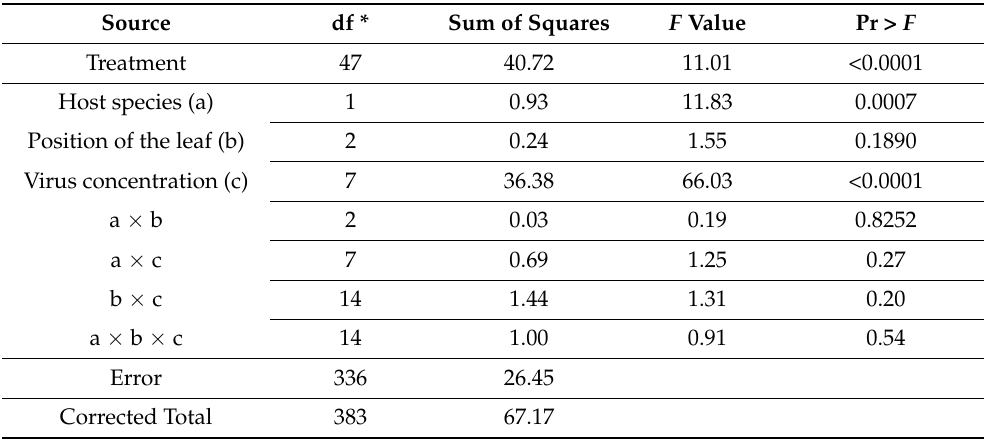
Table 5. ANOVA test results for evaluation of effects of leaf position and type of local lesion host on the number of local